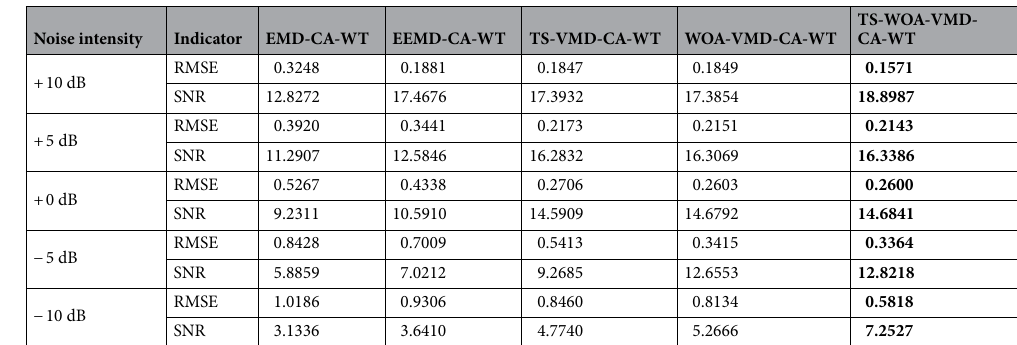
Table 2. The denoising effect of five methods for single frequency simulation signal.